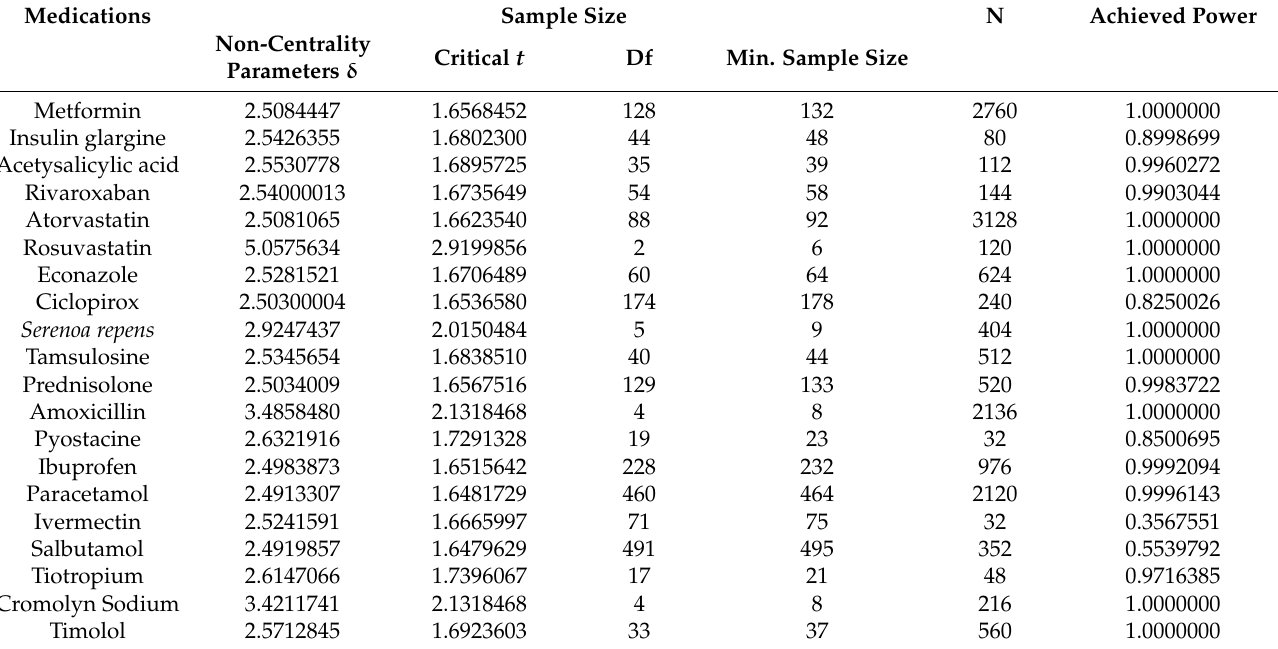
Table 2. Sample size and achieved power computations for each tested